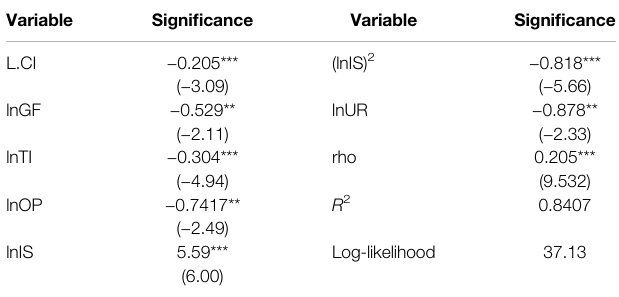
TABLE 13 | The results of the